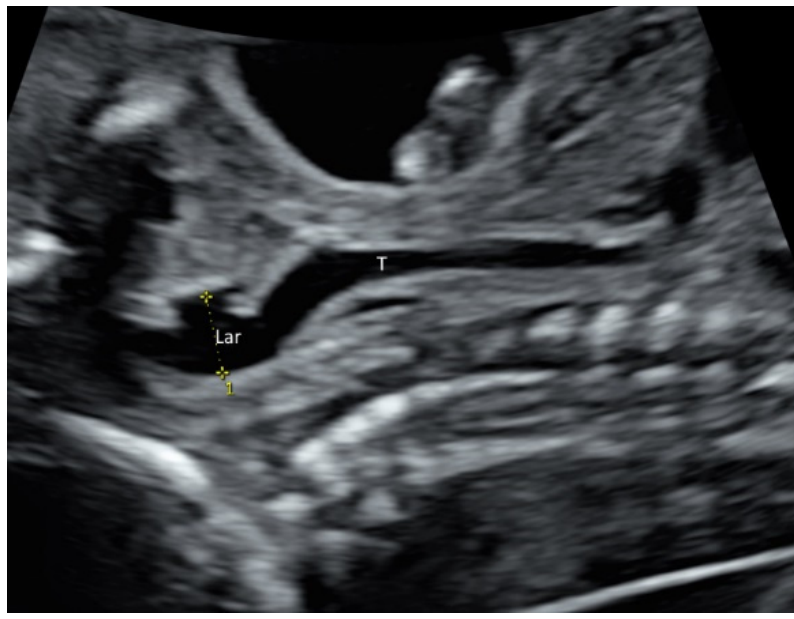
Figure 4. High-resolution ultrasonography of the fetal neck at 21 weeks’ gestation: sagittal view showing larynx (Lar) and trachea (T).